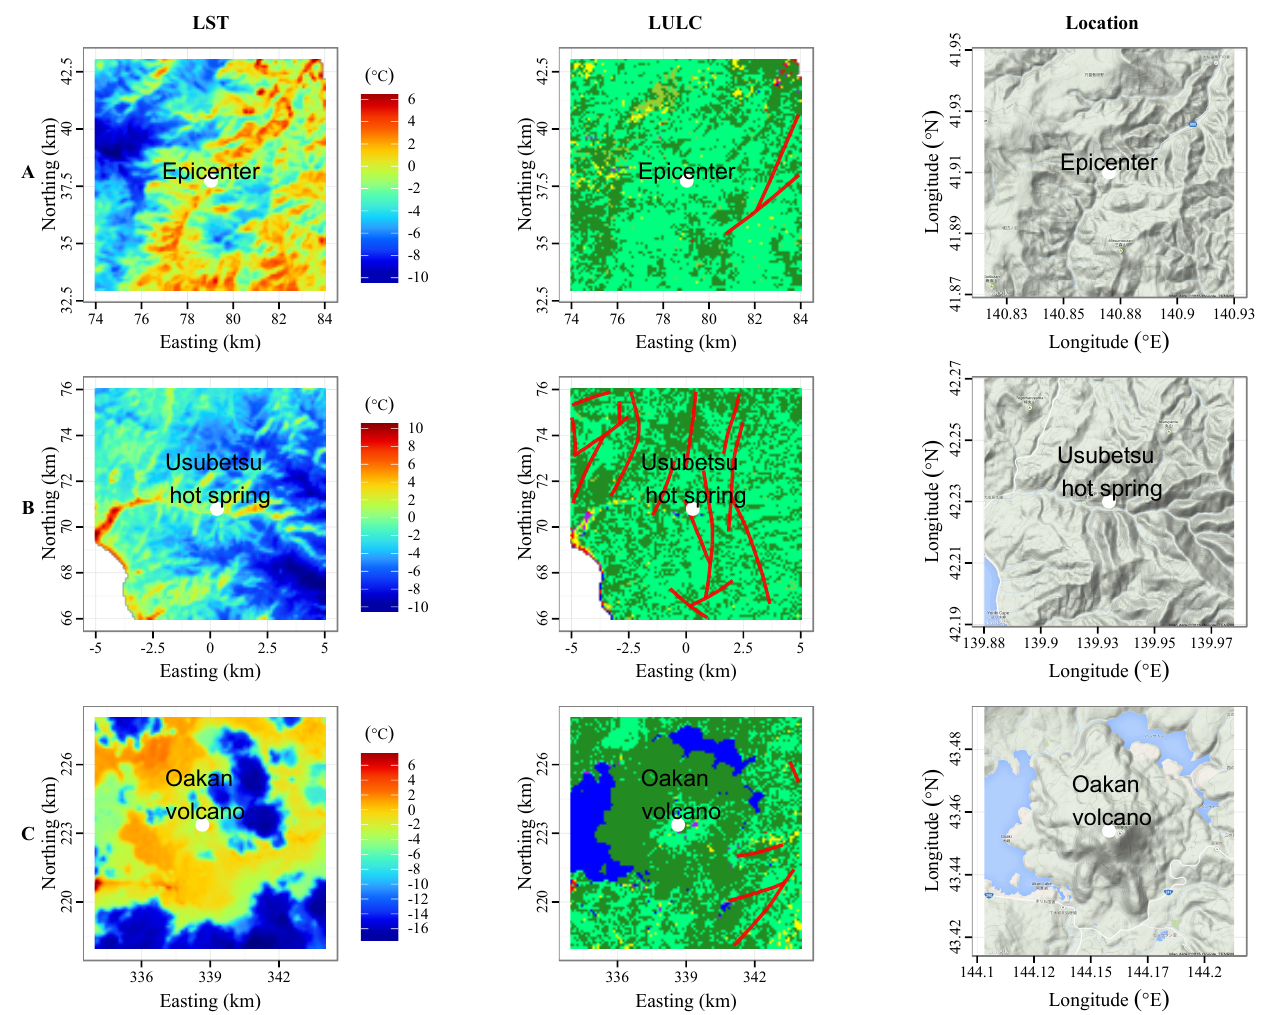
Figure 11. Comparison of Land Surface Temperature (LST) (derived from the scene average) and Land-Use and Land-Cover (LULC) in the three zones shown in Figure 10 which are situated at local high temperatures, specially > 150 ◦ C at 1500 m b.s.l. (Figure 9). The location maps are modified from Google terrain map. The red lines indicate faults. See Figure 6 for the color legend of